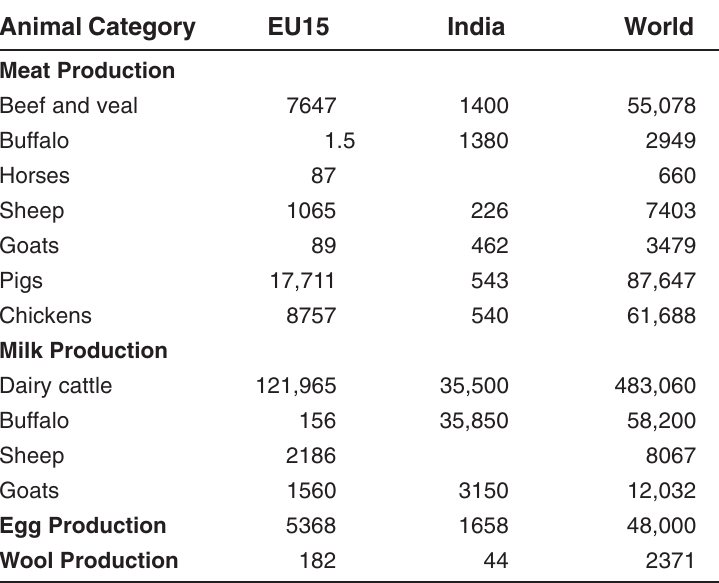
Nitrogen Excretion (in kg N) Per Animal Per Year for the Main Animal Categories Animal Category